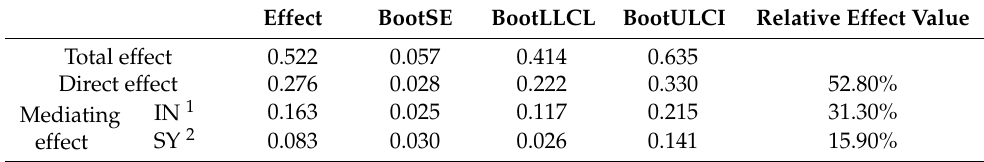
Table 7. The total effect, direct effect, and mediating effect of negative message